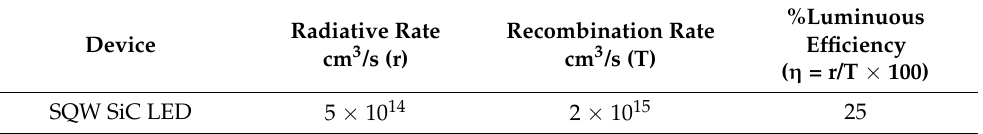
Table 2. Luminous efficiency calculations for simulated SiC LED at 39 kA/cm 2 bias.